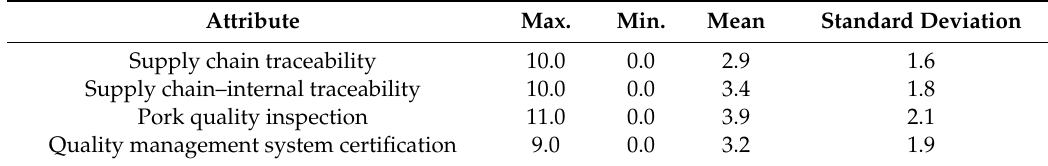
Table 2. Consumer maximum premium for di ff erent information attributes (price: yuan / 500 g).